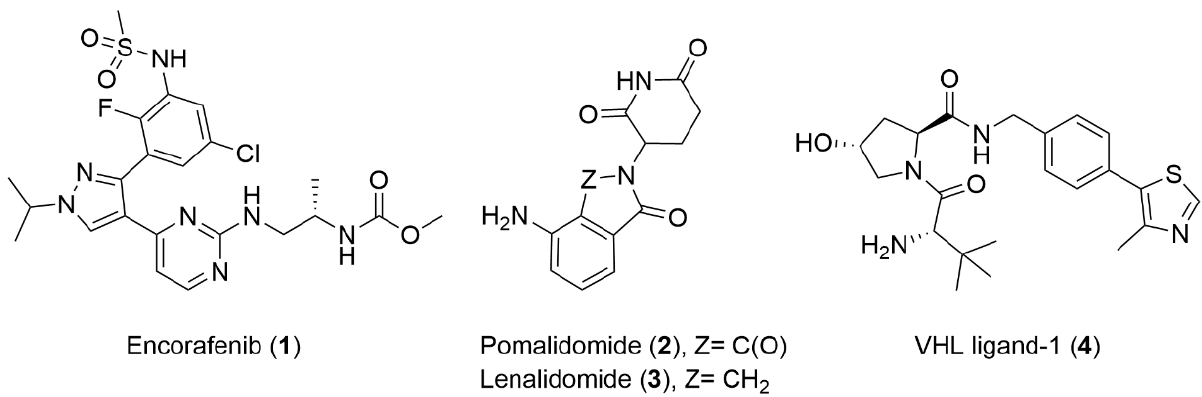
Figure 1. Chemical structures of encorafenib, pomalidomide, lenalidomide and VHL ligand-1.